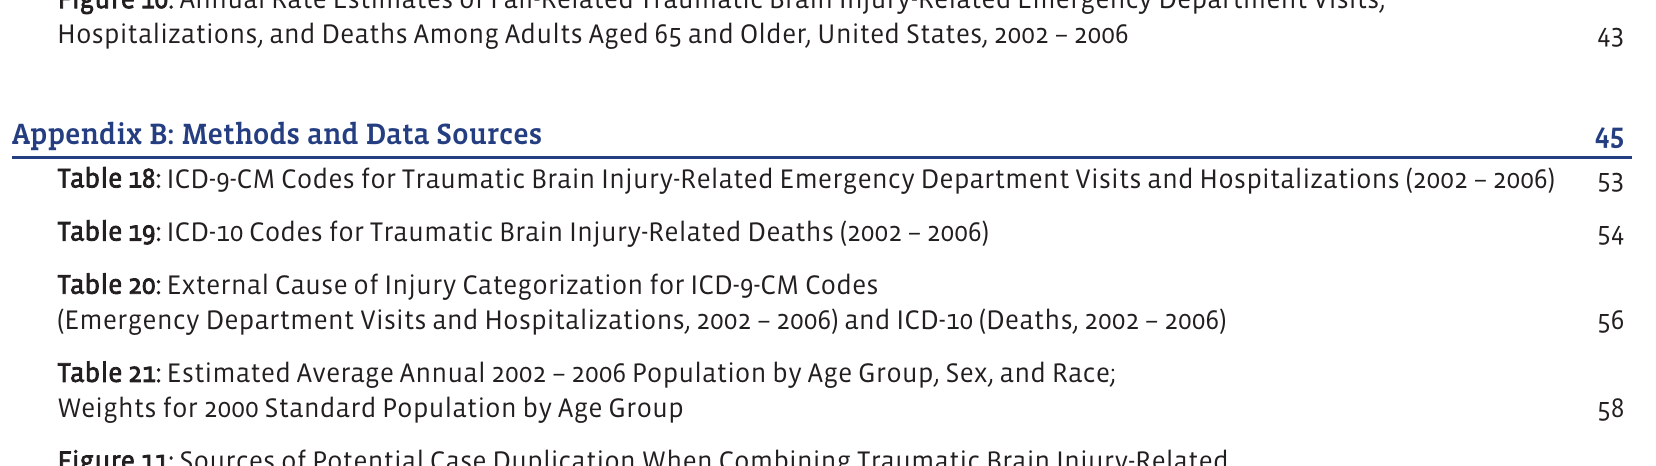
Table 14: Average Annual Numbers, Rates, and Percentages of Traumatic Brain Injury-Related Deaths, by Age Group and Sex, United States, 2002 – 2006 Table 15: Average Annual Numbers, Rates, and Percentages of Traumatic Brain Injury-Related Deaths, by Age Group and Race, United States, 2002 – 2006 Table 16: Average Annual Numbers, Rates, and Percentages of Traumatic Brain Injury-Related Deaths, by Age Group and External Cause, United States, 2002 – 2006 Table 17: Average Annual Numbers, Rates, and Percentages of Traumatic Brain Injury-Related Deaths, by Age Group and Specific Motor Vehicle – Traffic (MVT) External Causes , United States, 2002 – 2006 Figure 8: Annual Estimates of All Traumatic Brain Injury-Related Emergency Department Visits, Hospitalizations, and Deaths, United States, 2002 – 2006 Figure 9: Annual Rate Estimates of Fall-Related Traumatic Brain Injury-Related Emergency Department Visits, Hospitalizations, and Deaths Among Children Aged 0 – 14, United States, 2002 – 2006 Figure 10: Annual Rate Estimates of Fall-Related Traumatic Brain Injury-Related Emergency Department Visits, Hospitalizations, and Deaths Among Adults Aged 65 and Older, United States, 2002 – 2006